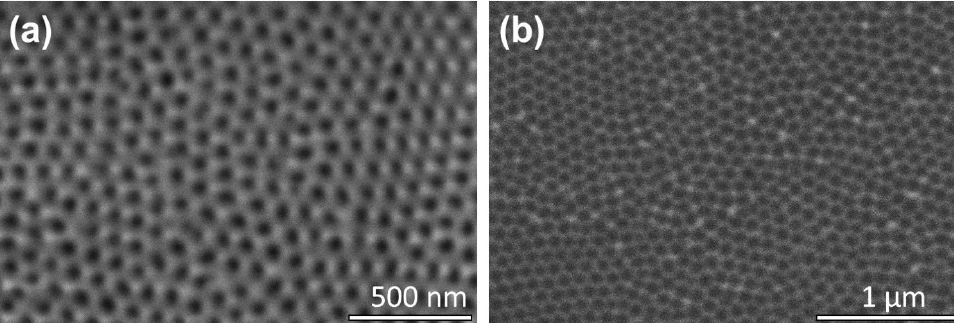
Figure 4. SEM image of: ( a ) the bare AAO template following the second 2 h anodization and pore widening for 10 min; ( b ) the nano-dimpled membrane after the second chemical etch that reduced the height of the